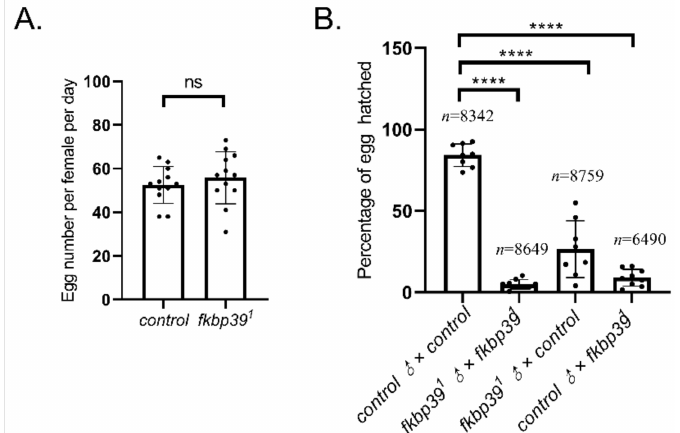
Figure 3. The fkbp39 mutant flies have fertility defects. ( A ) The number of eggs laid by wild-type or fkbp39 1 females. Error bars represent the S.D. of independent experiments. ( B ) The percentage of eggs successfully eclosed from the indicated fly genotype crossing. Error bars represent the S.D. of eight independent experiments. n is the total number of eggs examined. **** p < 0.0001; ns, not